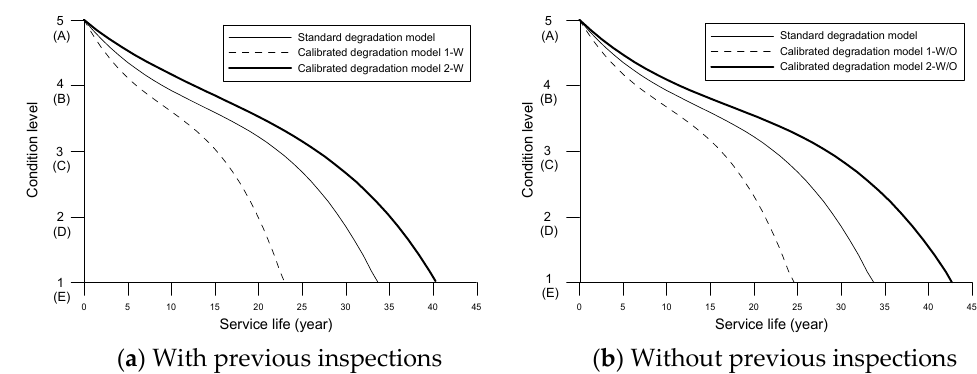
Figure 7. Calibration of the performance degradation model of the PSC-I girder.